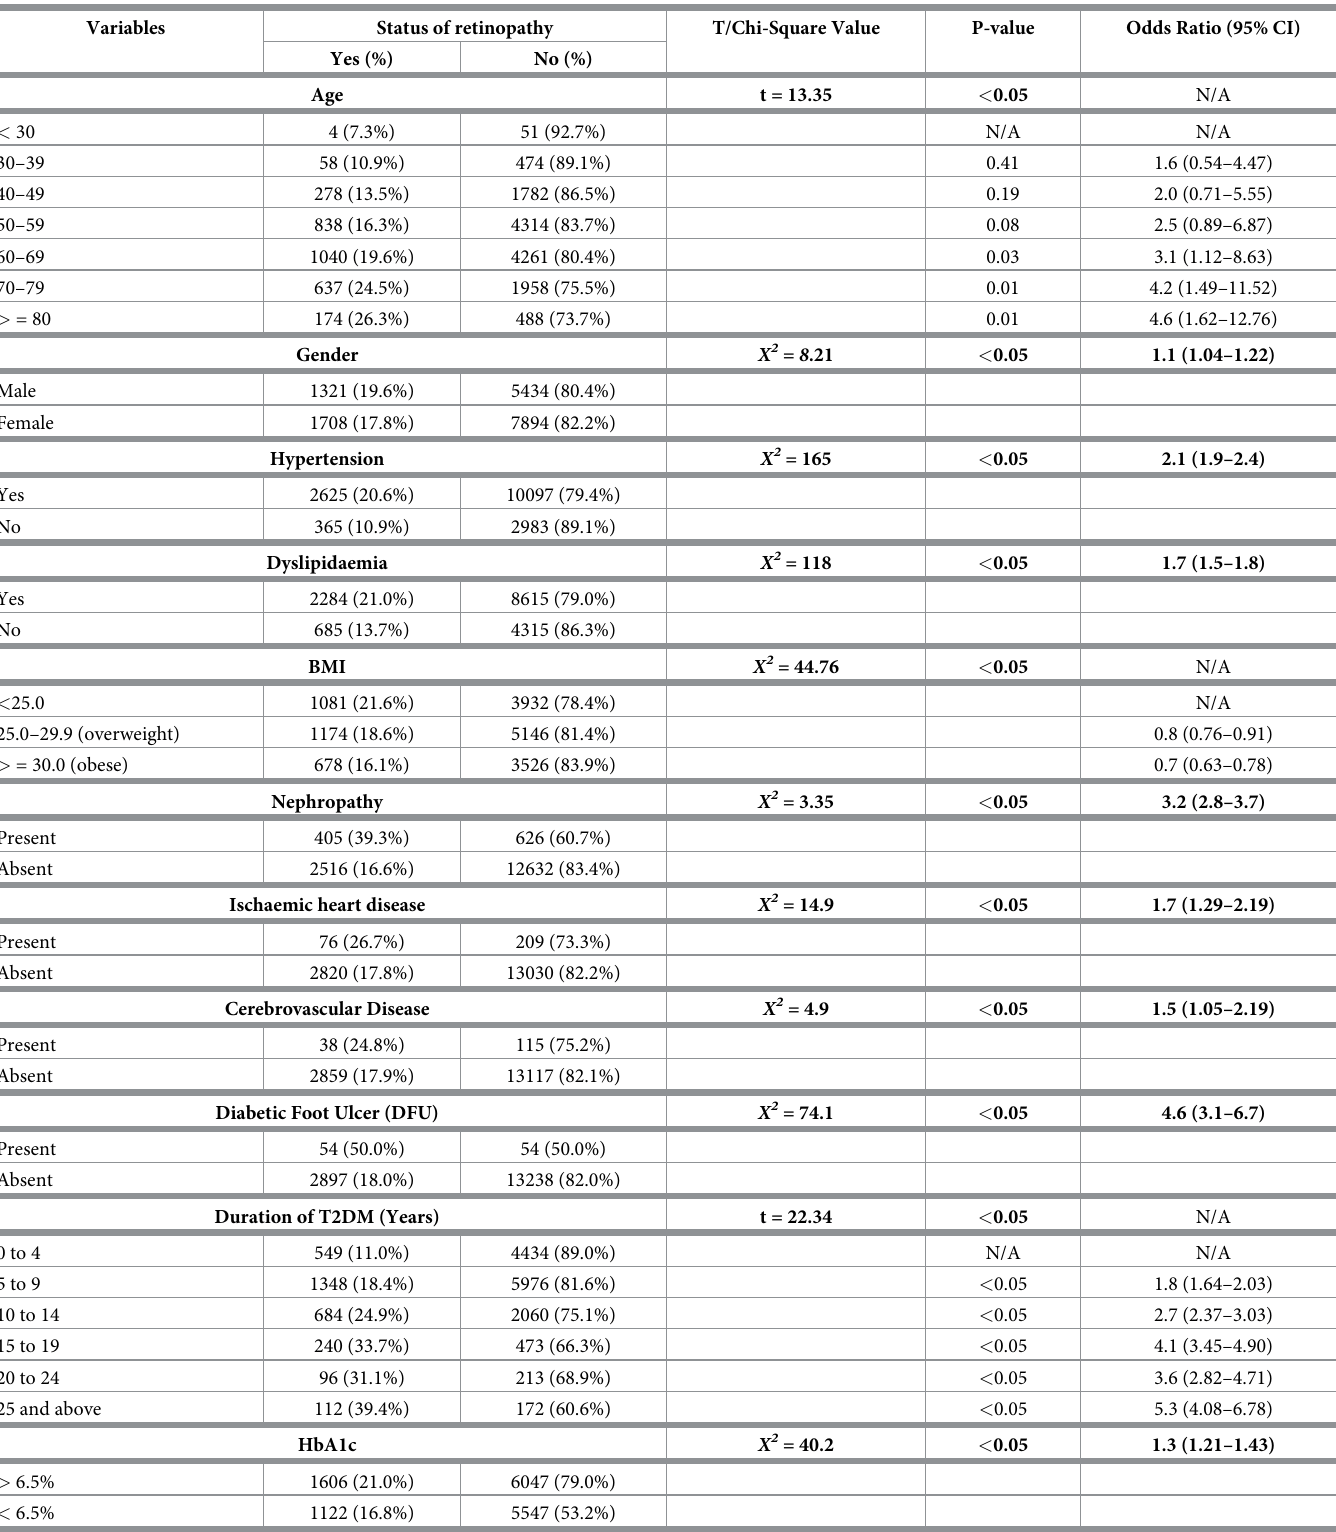
Table 1. Distribution of patients with diabetic retinopathy by risk